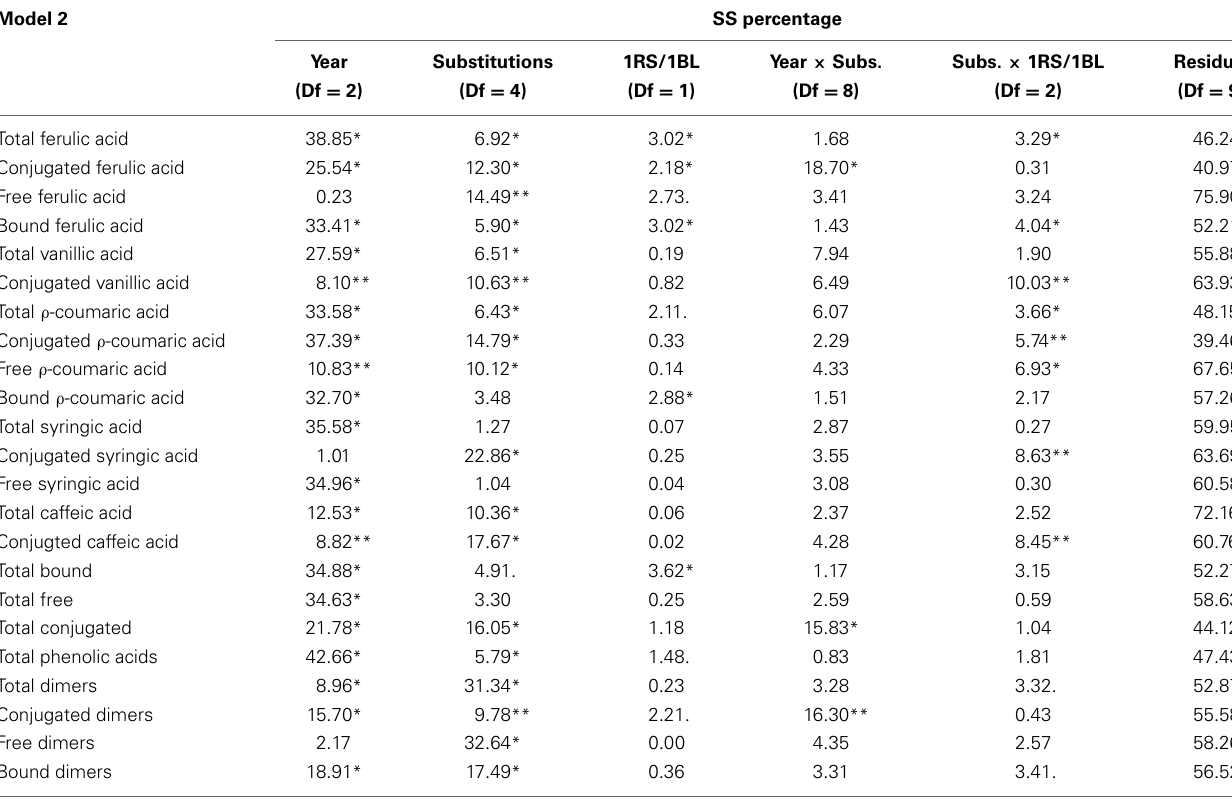
Table 4 | Table with the percentage of variance explained by each factors, derived from the ANOVA table of Model 2 (‘variable ∼ Year +